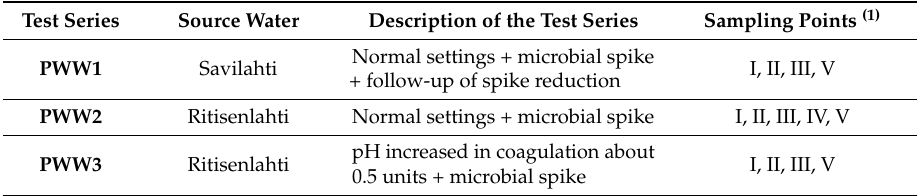
Table 1. Description of pilot scale test series and sampling points. PWW = pilot scale